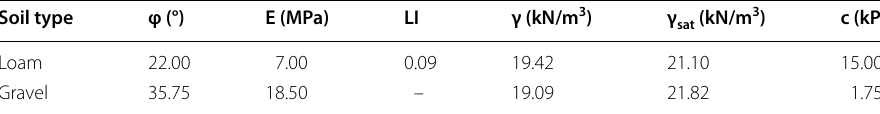
Table 2 Engineering soil properties for Astana soil profile Soil